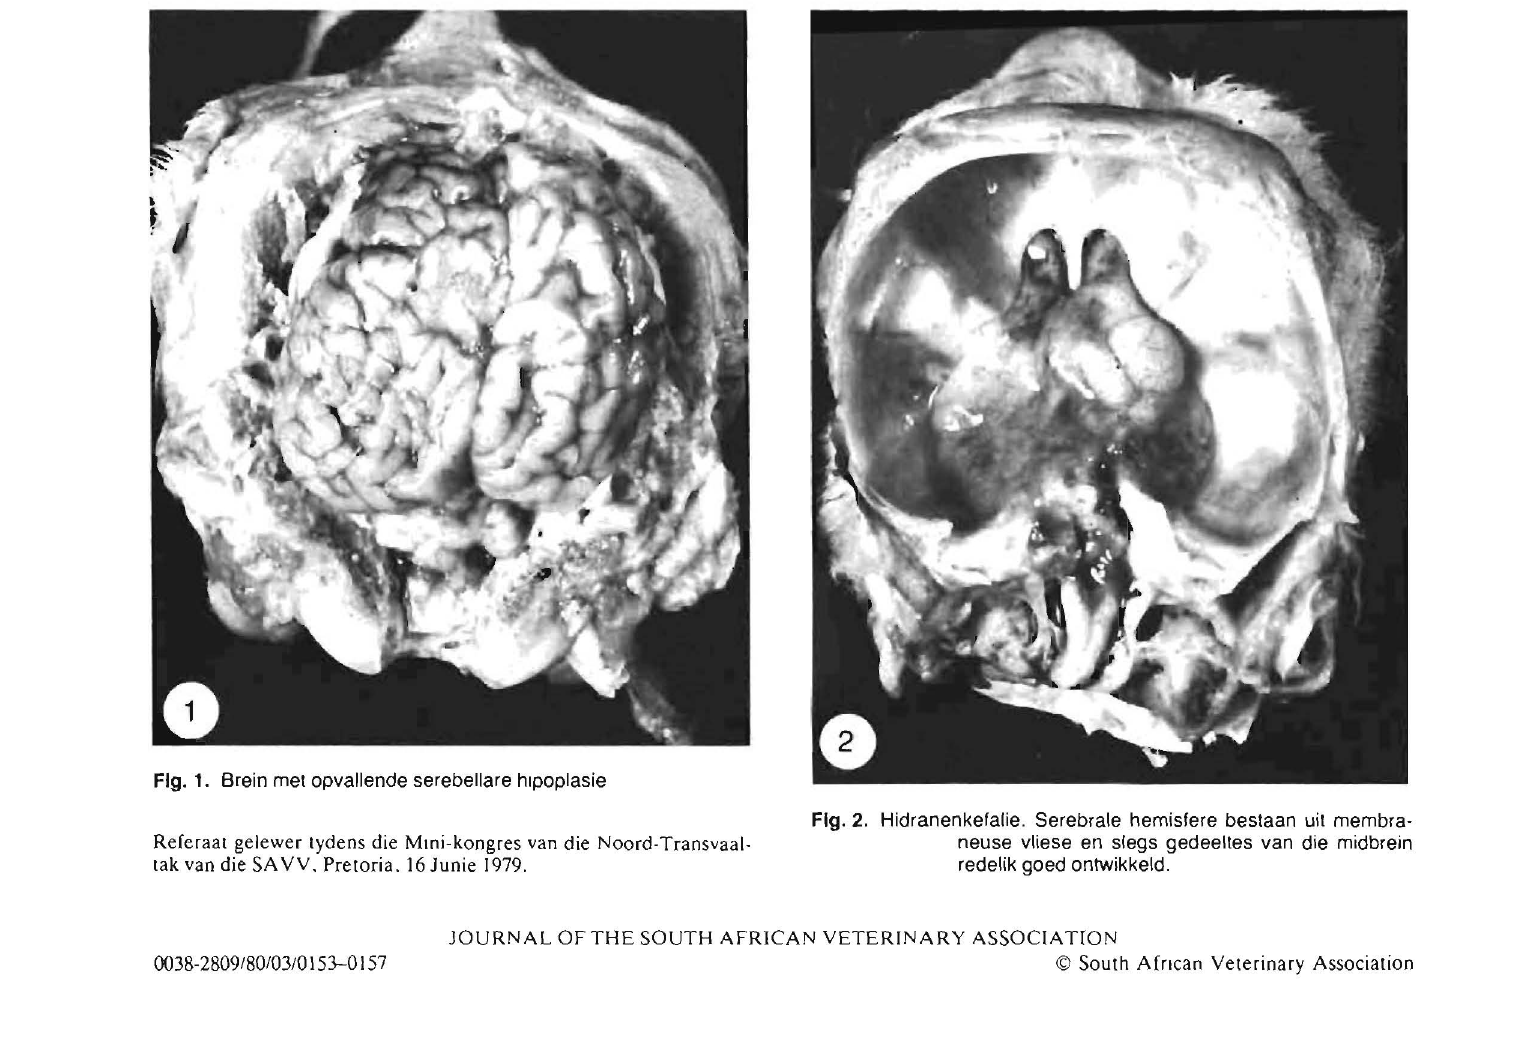
Fig. 2. Hidranenkefalie. Serebrale hemisfere bestaan uit membra neuse vliese en slegs gedeeltes van die midbrein redelik goed